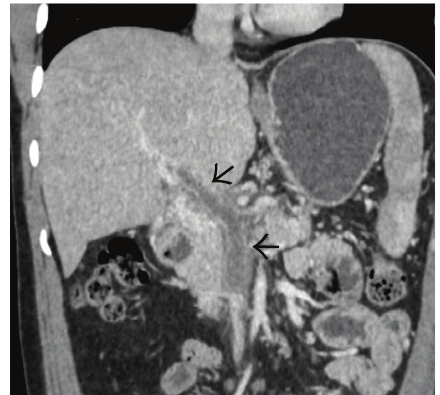
Figure 38: Coronal oblique CECT image demonstrating throm- bosed portal vein as well as the SMV (arrows) with rim- enhancement of their walls.